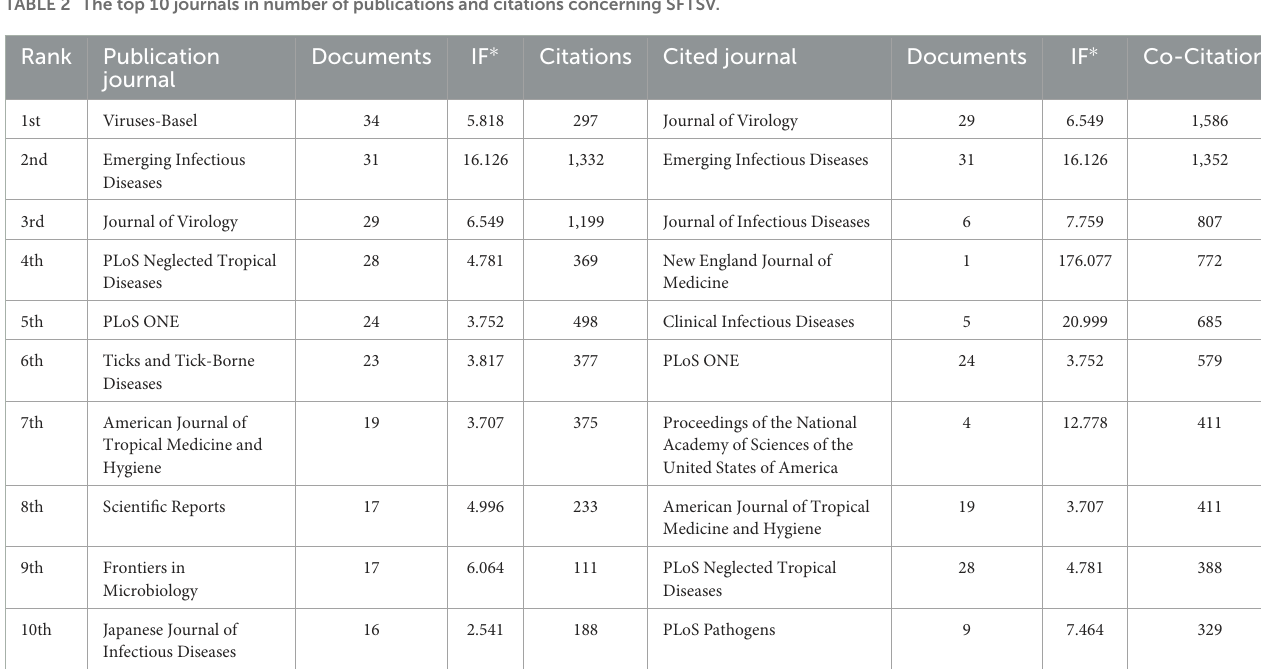
TABLE 2 The top 10 journals in number of publications and citations concerning